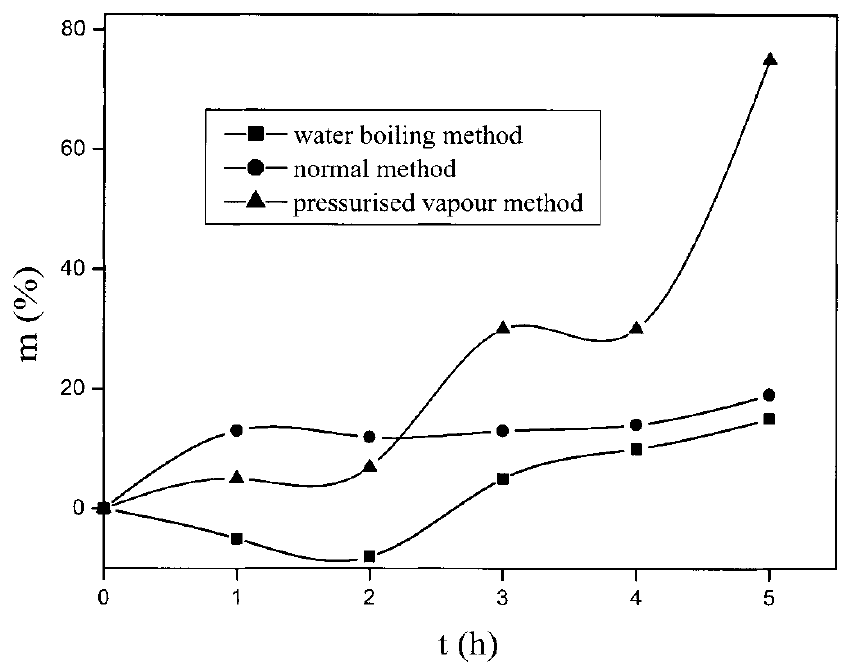
FIGURE 1 The relation of m and t for samples cured under 120 (cid:1) C